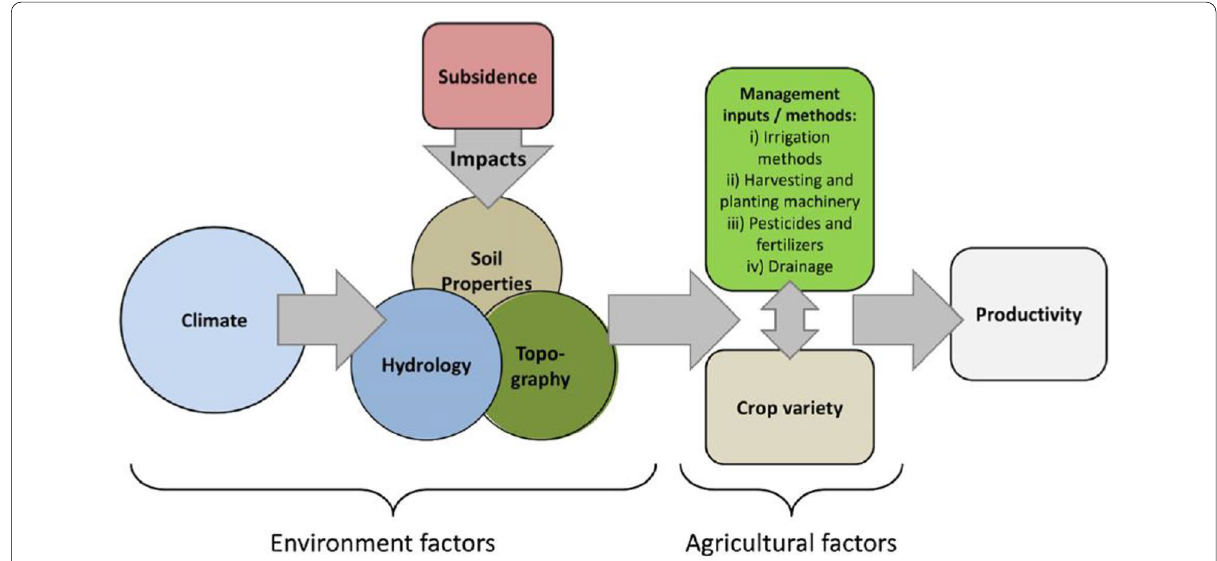
Fig. 2 Schematic diagram showing the impacts of coal mining subsidence on agricultural productivity (Lechner et al.